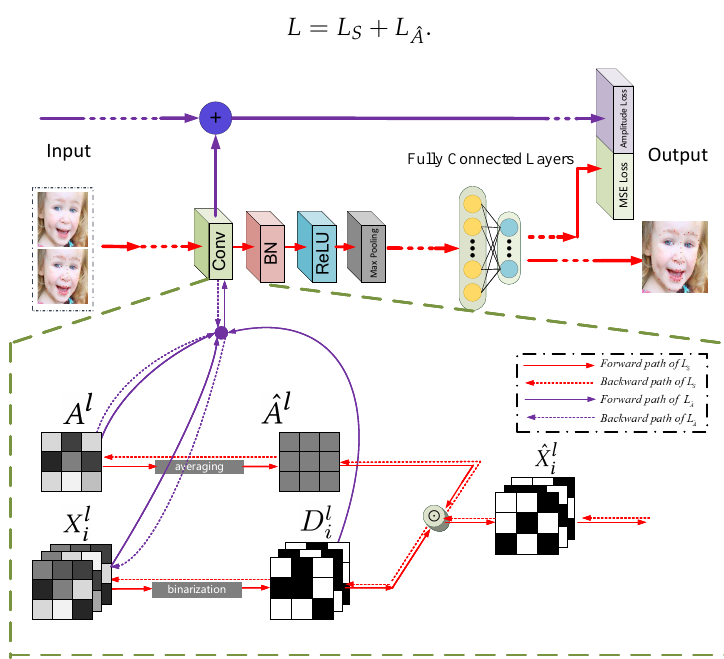
Figure 1. Facial landmark localization based on Amplitude Convolutional Networks (ACNs). ACNs are designed based on the convolutional kernels’ directions D l and amplitude matrices A l . The amplitude i matrices are particularly designed to efficiently approximate the unbinarized convolutional filters in the end-to-end framework. Since an amplitude matrix is shared at each layer, ACNs are high compressed. The full-precision convolutional kernels X l are quantized to D l via the sign function. i i Both the new loss L ˆ and the traditional loss L S are used to train ACNs. We illustrate our network A structure based on conventional Convolutional Neural Networks (CNNs), and more specific details are shown in the dotted box. (cid:12) indicates the element-wise multiplication between matrices. Note that the amplitude matrices A l and the full-precision kernels X l are not used in the inference. ACNs have i binarized kernels. To compress CNNs, 1-bit ACNs are proposed based on ACNs by further binarizing the full-precision feature maps of ACNs into binary feature